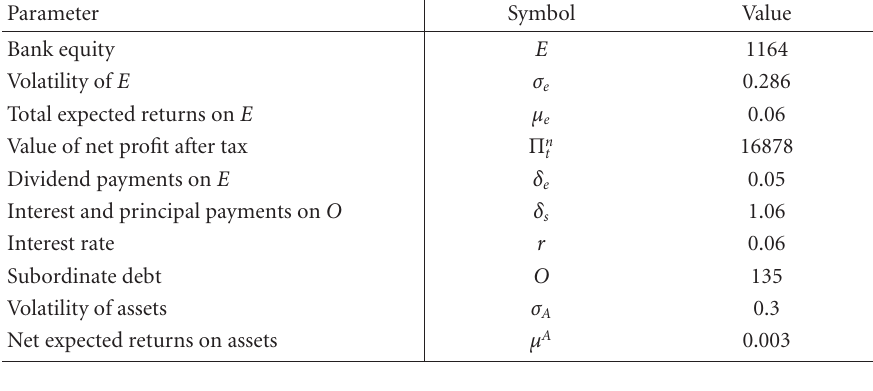
Table 4.2. Parameter choices for the ROE and ROA simulation.